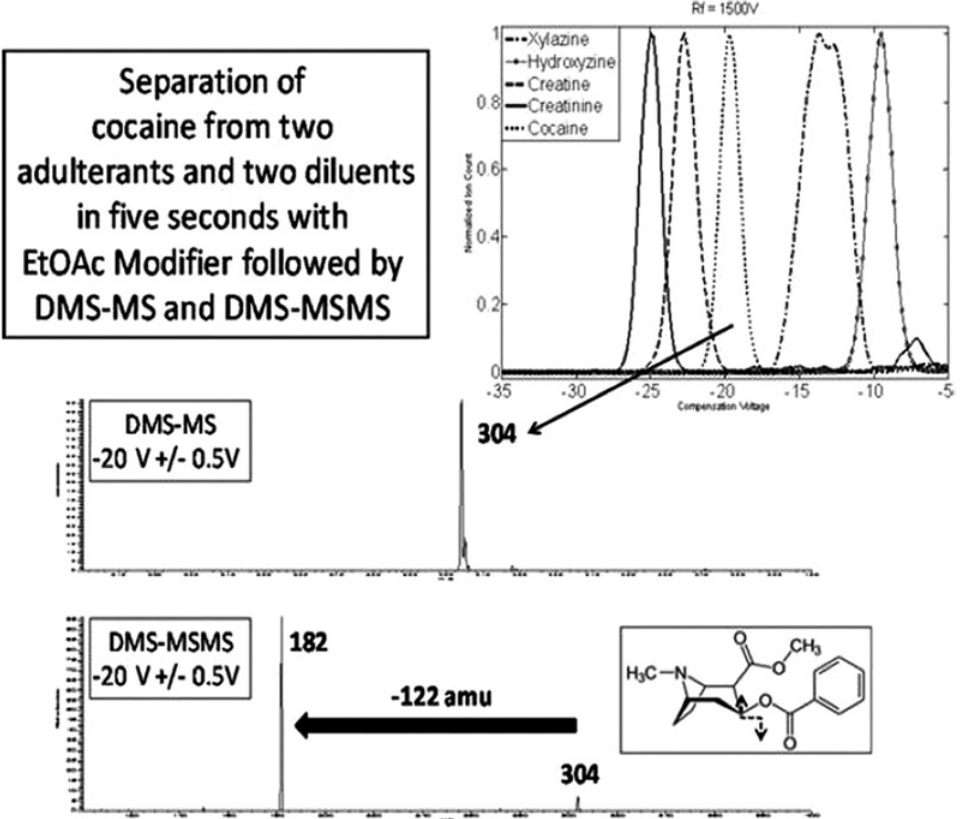
Figure 5: Detection of four additives and cocaine by